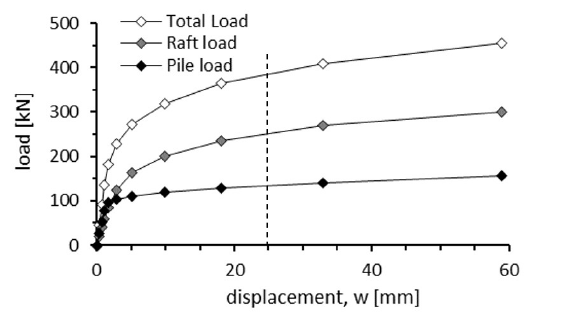
Figure 21. Load-settlement curves for case 14 - L=6m;